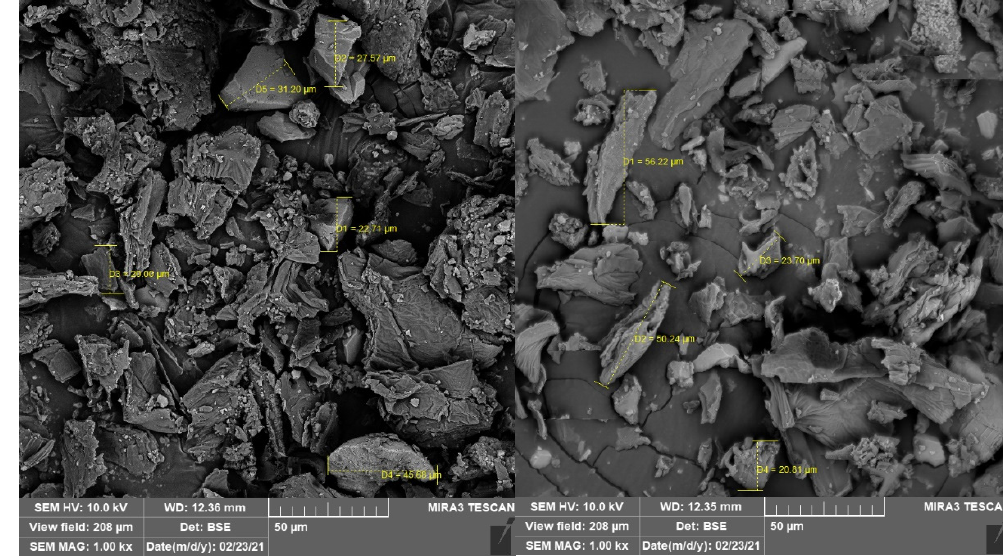
Figure 2. MF particle size (1000×).